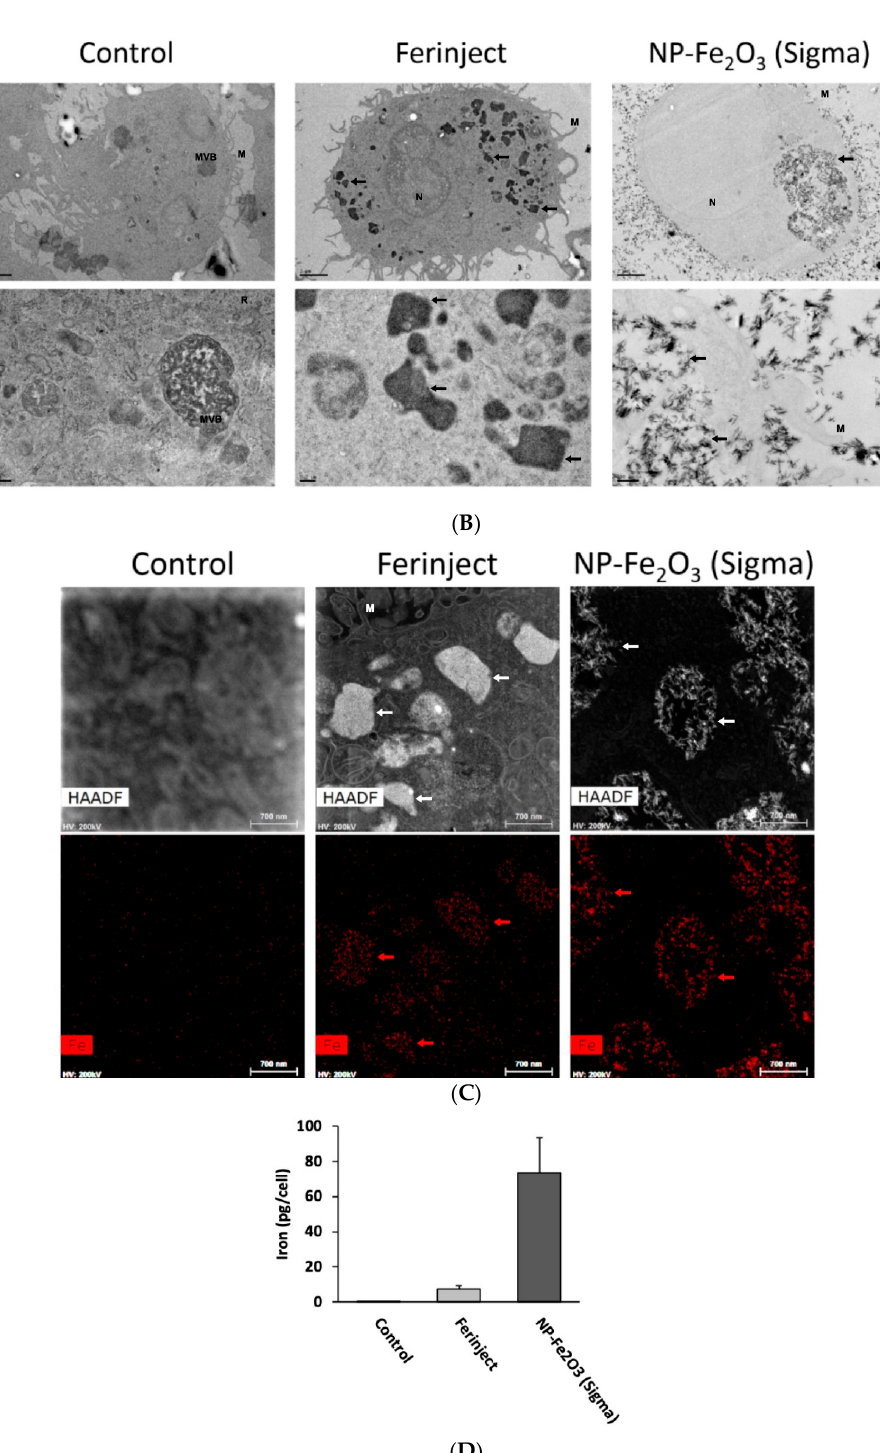
Figure 3. The presence of iron and nanoparticles in J774A.1 cell line incubated 24 h with or without FERINJECT ® or Fe 2 O 3 -NP Sigma. Panel ( A ): Perls staining. Blue staining: complex KFe [Fe(CN)6] named Prussian blue. Red staining: Safranin cytosolic staining; Panel ( B ): TEM microscopy. Scale bar, top line = 2 μ m; below line = 0.5 μ m (Control) or 0.2 μ m (FERINJECT ® and Fe 2 O 3 -NP Sigma). Panel ( C ): Top line: HAADF (High-Angle Annular Dark Field microscopy) with, in white high-density zone. Below line: EDX (Energy Dispersive X-ray Analysis) with, in red iron elements. N = Nucleus; M = Microvillosity; R = Reticulum; MVB = Multivesicular bodies; arrow = vesicle with iron particles. Panel ( D ): Quantitative assessment of the iron engulfed by macrophages using the bathophenanthroline